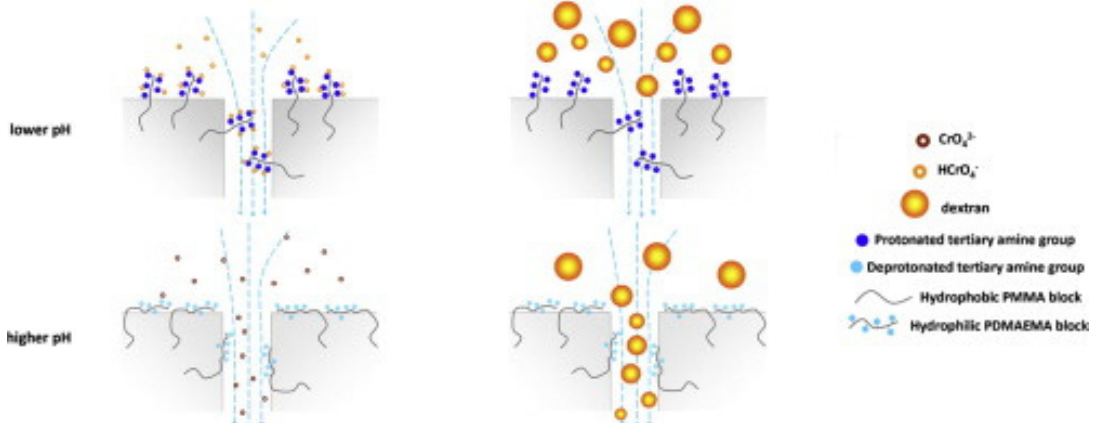
Figure 13. Schematization of the mechanism of adsorption of TSA membranes: the membrane sieving ability depends on the pH. At low pH, the amine groups are protonated and therefore able to attract the negative molecular ions of chromium; at high pH, the amine groups are neutral allowing the ion passage through the membrane and then avoiding their adsorption. Reproduced with permission from [166], copyright of Elsevier B.V.